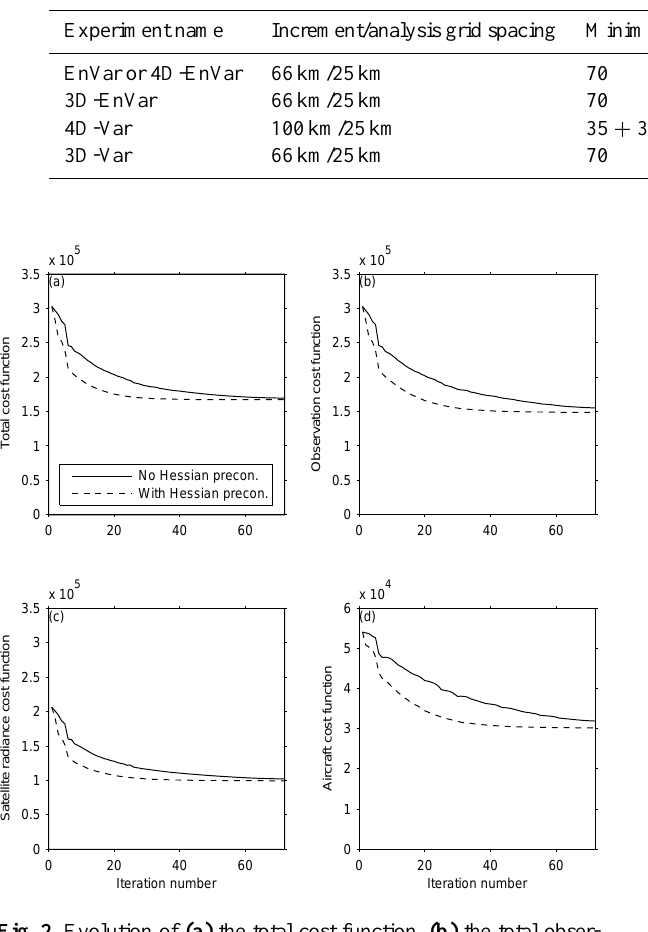
Fig. 2. Evolution of (a) the total cost function, (b) the total obser- vation cost function, (c) the cost function for satellite radiance ob- servation, and (d) the cost function for aircraft observations. These are shown for a single EnVar minimization without Hessian pre- conditioning (solid line) and with Hessian preconditioning from the previous analysis cycle (dashed